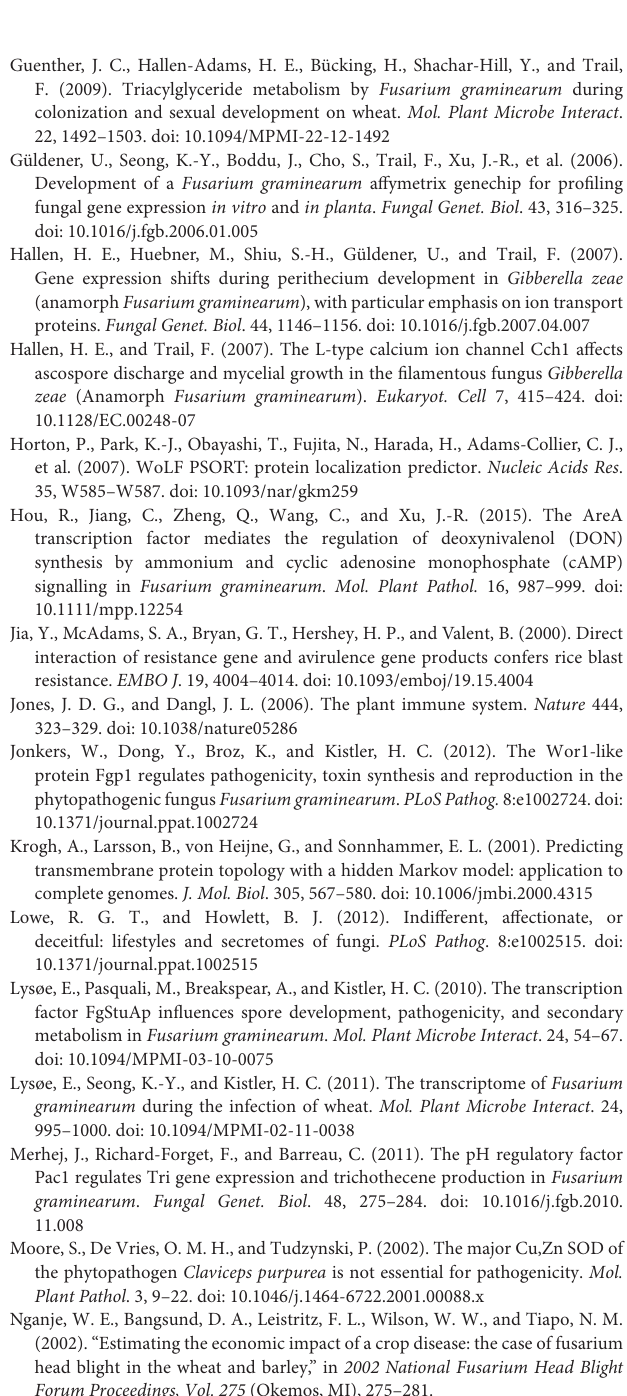
Table S2 | Cellular proteome identifications. Table S3 | Label-free quantitation. Table S4 | Limma statistical analysis. Table S5 | Signal peptide